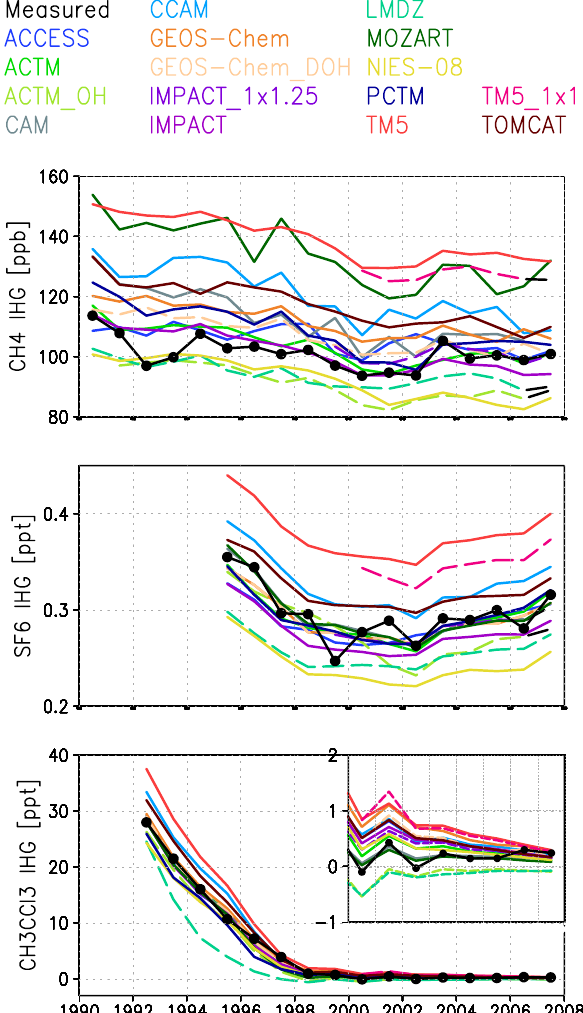
Fig. 7. Interhemispheric gradients (IHGs) for CH 4 CTL , SF 6 and CH 3 CCl 3 concentrations between the NH (BRW, MLO) and SH (CGO, SPO) sites. The values at CGO (AGAGE) are adjusted to NOAA scales by adding an offset of 0.02ppt for SF 6 , and multi- plied by 1.0003 and 1.0333 for CH 4 and MCF, respectively (see text in Sect. 2.4 for further details). Please note that adjustment of the AGAGE data to NOAA scale is made just for convenience. These 4 sites are chosen here because their data coverage is most complete during 1990–2007. Haley Bay (75.58 ◦ S, 26.5 ◦ W, 10m) site is chosen for PCTM due to no SPO data in all files. Inset shows expanded y-axis view of MCF for the 2000–2007 period.